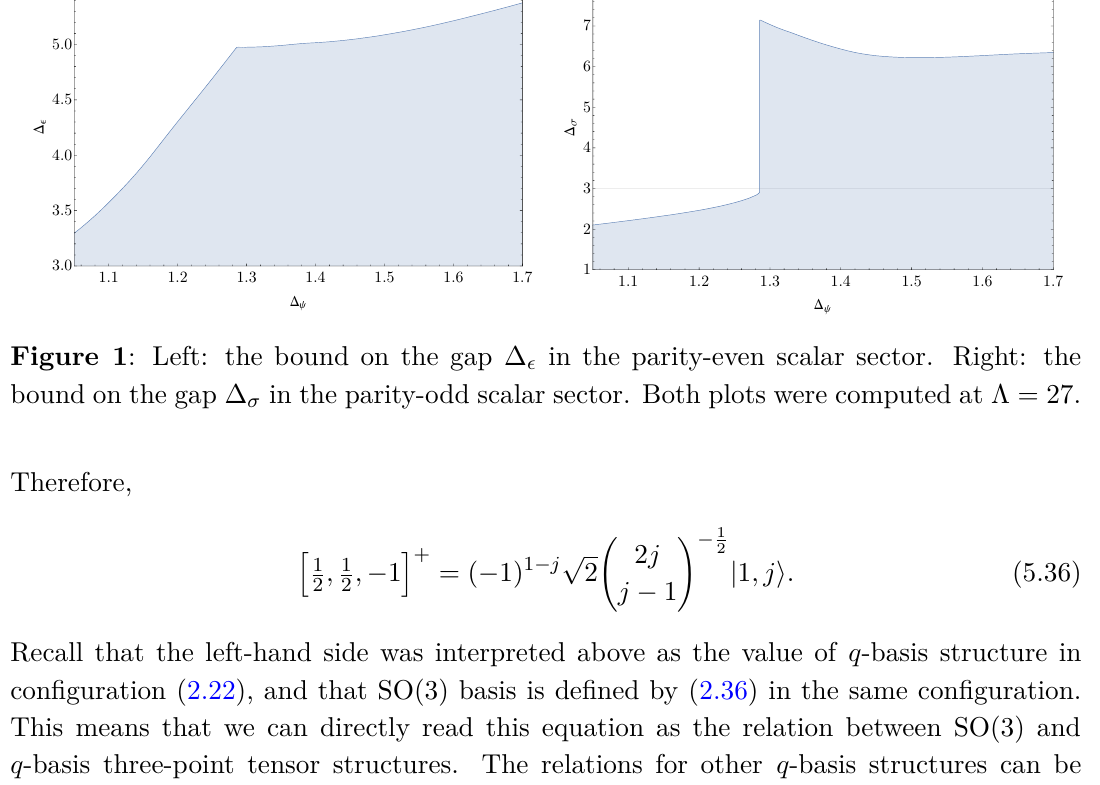
in the parity-even scalar sector. Right: the (cid:15)